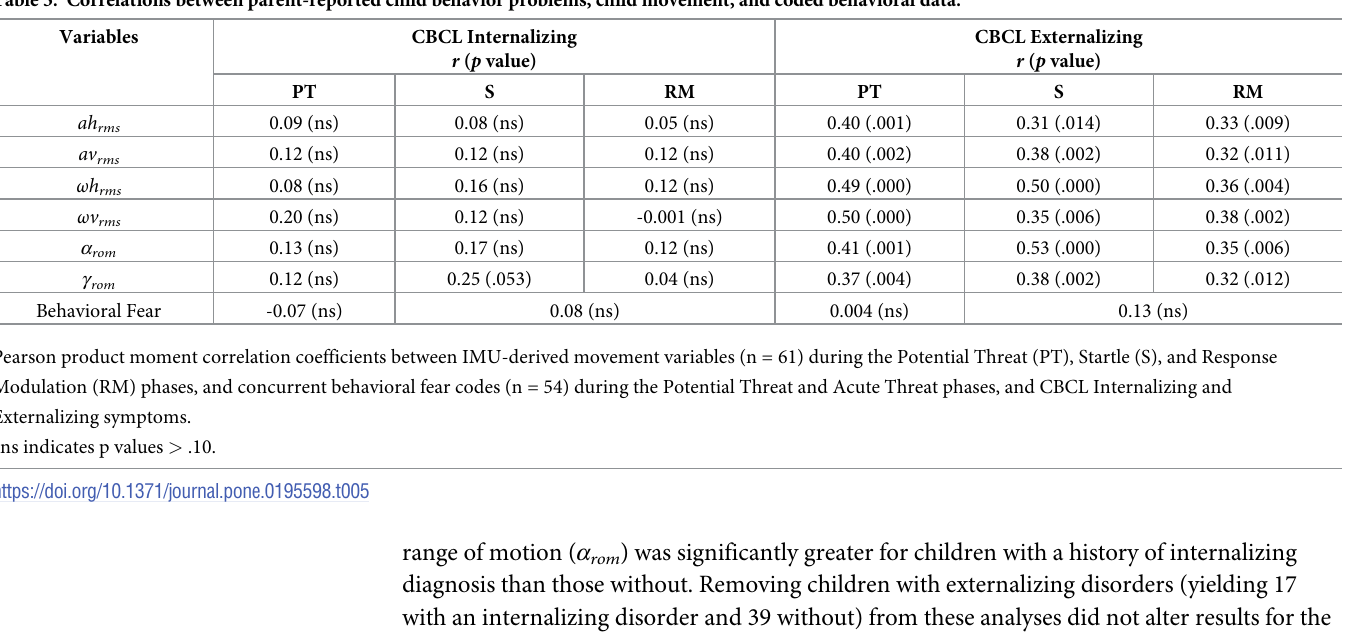
range of motion ( α ) was significantly greater for children with a history of internalizing rom diagnosis than those without. Removing children with externalizing disorders (yielding 17 with an internalizing disorder and 39 without) from these analyses did not alter results for the Potential Threat phase. However, bending range of motion during the Startle phase were no longer significantly different and thus should be interpreted with caution. Behavioral fear codes were not significantly different between children with and without histories of internal- izing diagnosis in either the Potential Threat or Acute Threat phases.